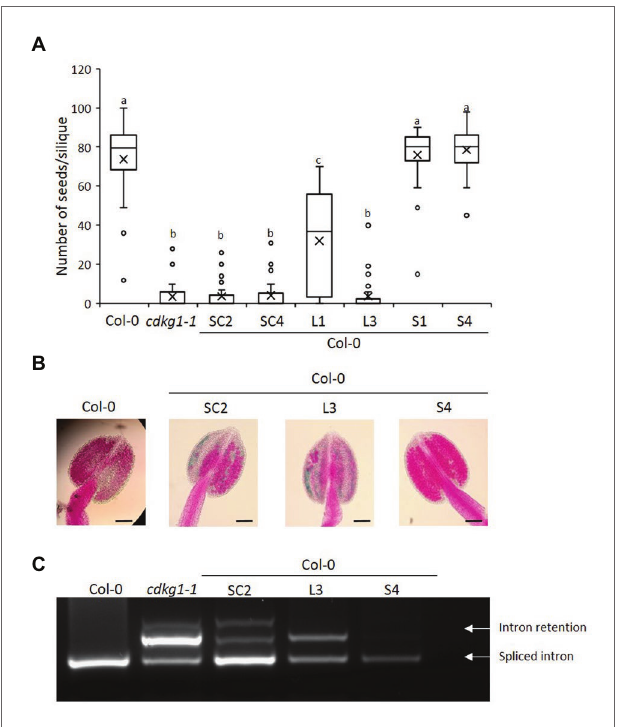
FIGURE 4 | Increased expression of CDLG1L decreases fertility in a Col-0 background. (A) Fertility counts of Col-0 plants transformed with the different CDKG1-GFP constructs. The average number of seeds per silique was determined for Col-0, cdkg1-1 , and lines expressing the various constructs under the control of the CDKG1 promoter in a Col-0 background as indicated. Data represent average and the interquartile range for 30 siliques from three plants. Superscript letters represent significance groups for p < 0.001. (B) Pollen viability staining of the lines above. Round carmine- colored pollen grains are viable, while white/blue shrunken pollen is not viable. Scale bar = 100 μ m. (C) Splicing profile of the CalS5 mRNA in young inflorescences of the different lines as described above. The CDKG1SC-GFP and CDKG1L-GFP lines show the intron retention observed in the cdkg1-1 mutant. The extra high molecular weight band observed in some of the samples is possibly a result of RNA heteroduplex formation.